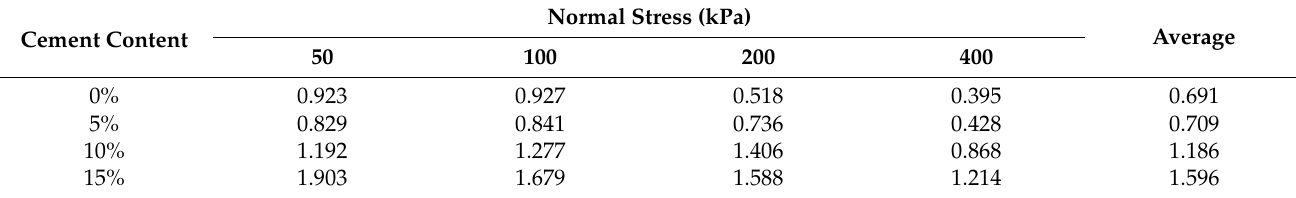
Table 6. Model parameter b under different grouting conditions.